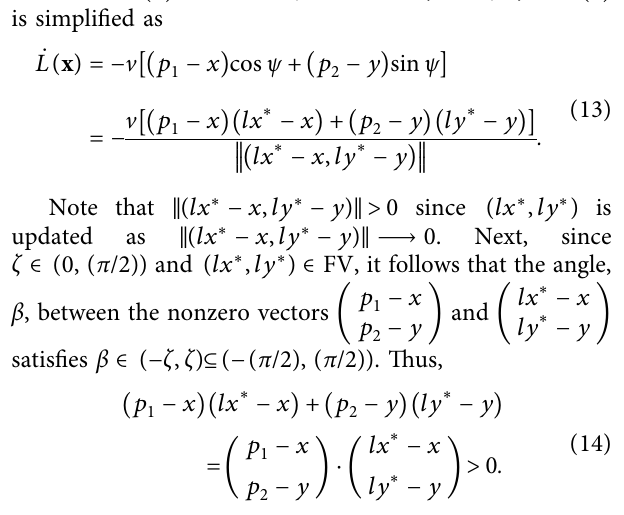
Figure 5: Evolution of the Lyapunov function (solid line) and its derivative (dashed line) for the trajectory shown in Figure